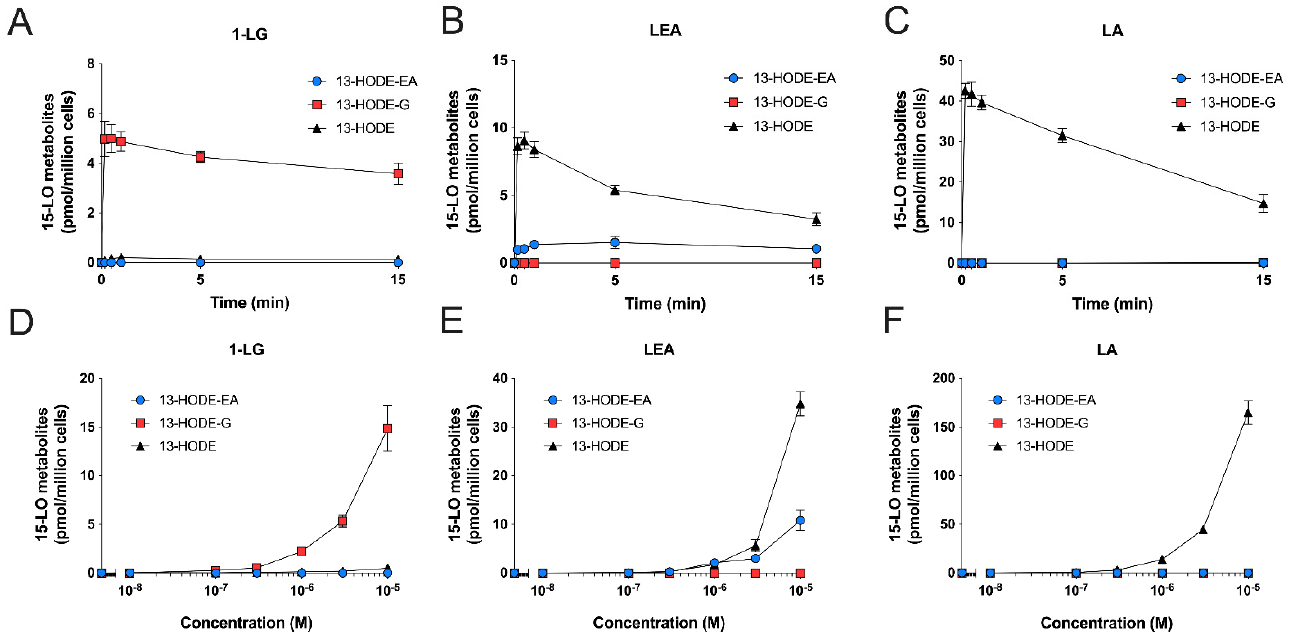
Figure 7. Time- and concentration-dependent biosynthesis of 15-LO metabolites from 1-LG, LEA, and LA by human neutrophils. Pre-warmed human neutrophils suspensions (37 ◦ C, 5 × 10 6 cells/mL in HBSS containing 1.6 mM CaCl 2 ) were treated with 3 µ M of ( A ) 1-LG, ( B ) LEA, or ( C ) LA for the indicated times. ( D – F ) Neutrophils were treated with increasing concentration of ( D ) 1-LG, ( E ) LEA, or ( F ) LA for 5 min. In experiments involving 1-LG, cells were pretreated with 1 µ M MAFP for 5 min prior to the addition of 1-LG. Incubations were stopped by the addition of one volume of cold ( − 20 ◦ C) MeOH containing the internal standards. Samples then were processed for LC-MS/MS analyses as described in methods. Data are the mean (±SEM) of 4 independent experiments.